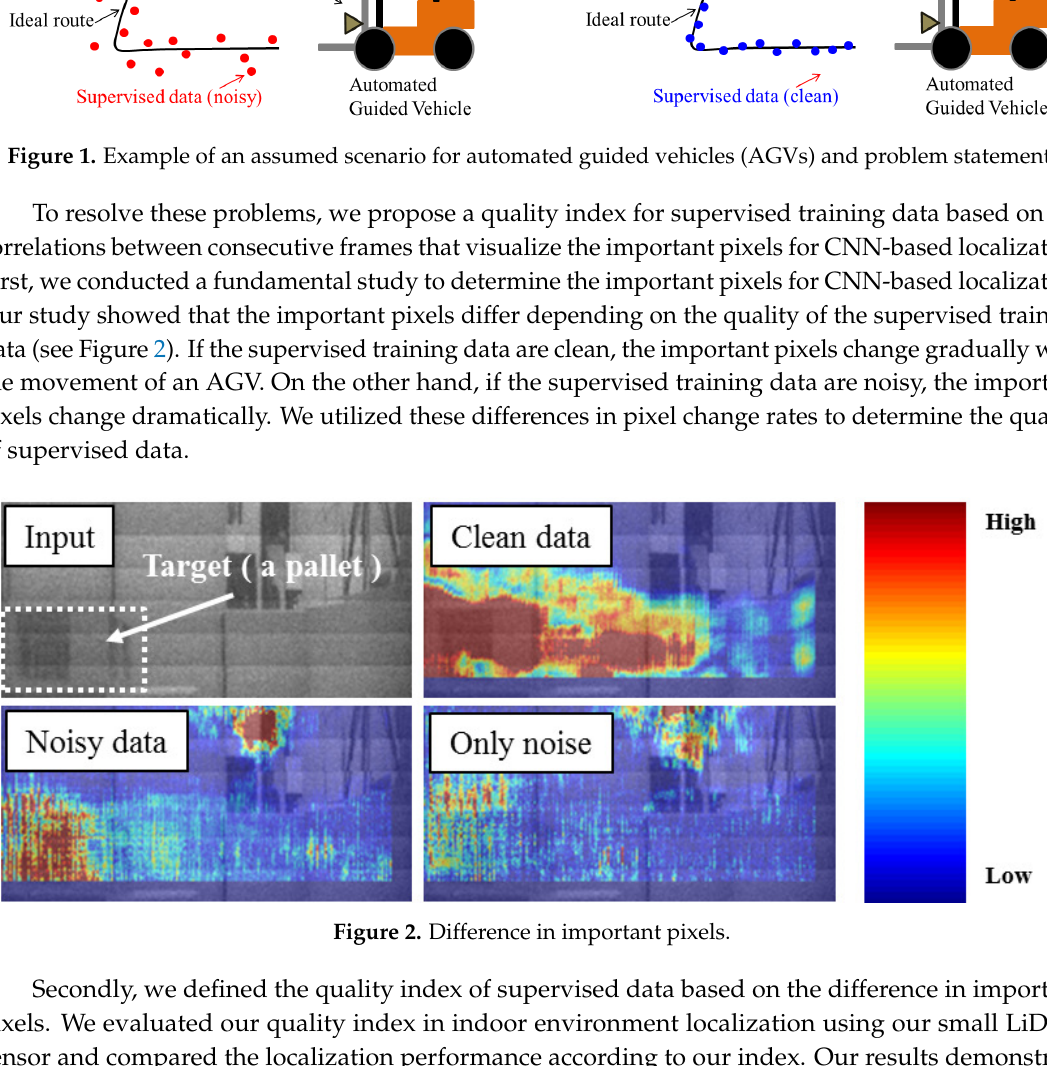
Figure 2. Difference in important pixels.